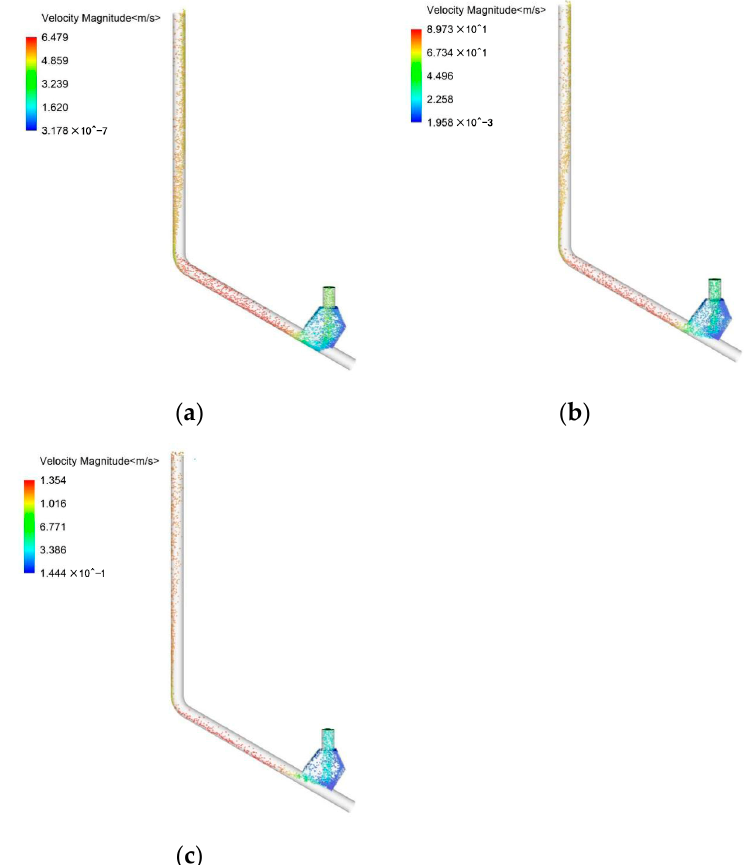
Figure 8. Additional simulations under higher conveying velocities: ( a ) v p = 4 m/s, v f = 2 m/s; ( b ) v p = 4 m/s, v f = 4 m/s and ( c ) v p = 4 m/s, v f = 8 m/s.